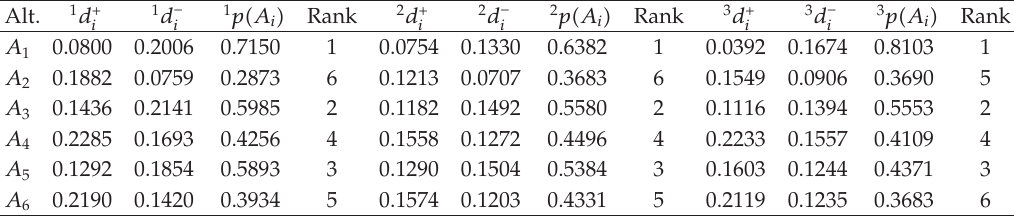
Table 9: Application of the fuzzy TOPSIS for decision makers with weights.